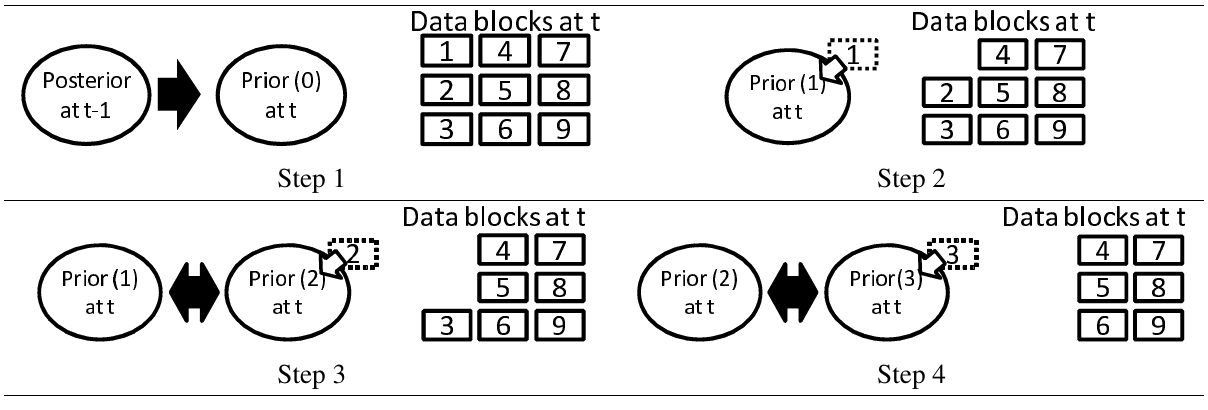
Figure 3. Serial